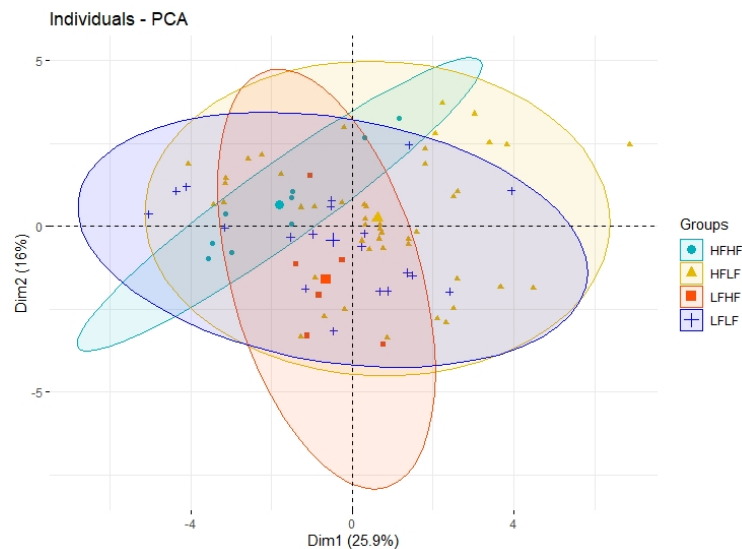
Figure 2. Clustering of the categorical variable, including the four fatness and fitness permutations. Relationship between the first principal component and the second principal component computed by PCA. The size of the icons for the single individuals shows their weight in classification. HFHF = Higher-Fatness with Higher-Fitness group, HFLF = Higher-Fatness with Lower-Fitness group, LFHF = Lower-Fatness with Higher-Fitness group, LFLF = Lower-Fatness with Lower -Fitness group.